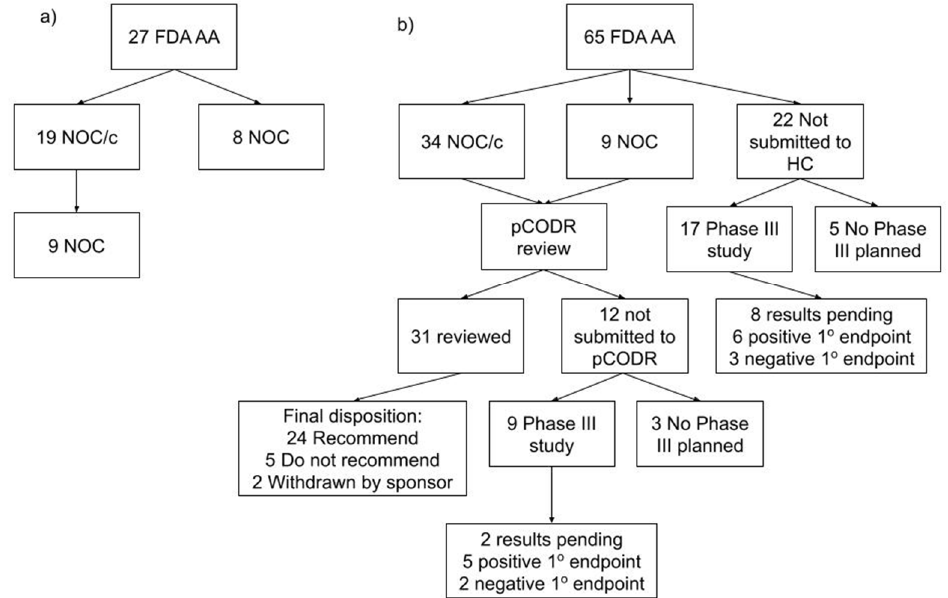
Figure 3. Consort diagram. ( a ) Accelerated approvals by the FDA and the corresponding Health Canada decisions from 2000 to 2010. ( b ) Accelerated approvals by the FDA and the corresponding Health Canada and pCODR decisions from 2011 to 2019. (AA—accelerated approval, FDA—Food and Drug Administration, HC—Health Canada, NOC/c—notice of compliance conditional, NOC—notice of compliance, pCODR—pan-Canadian Oncology Drug Review).